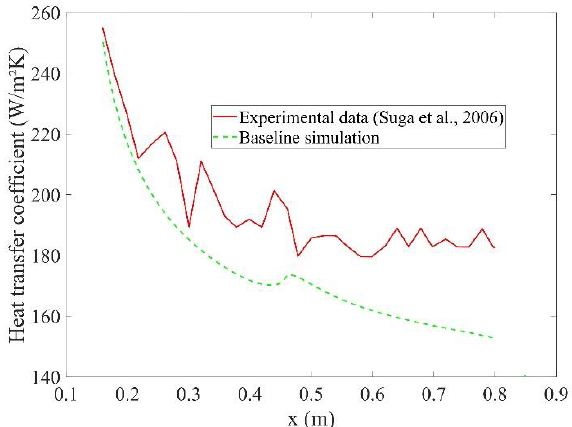
Figure 4. Baseline results before calibration.